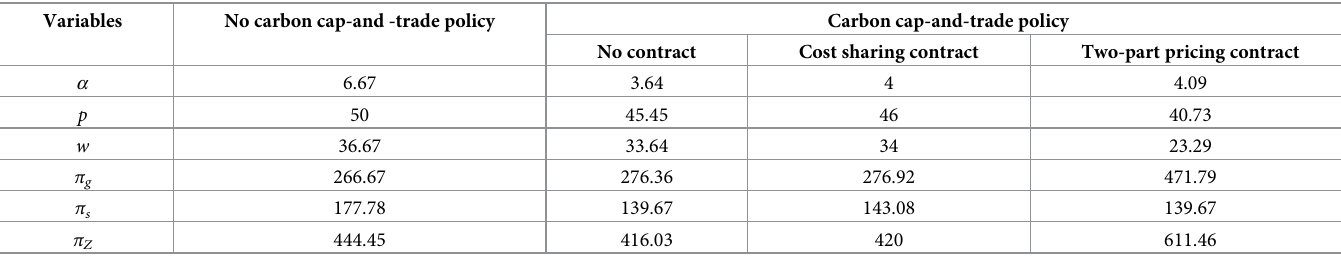
Table 1. Optimal decision-making and revenue under different modes.